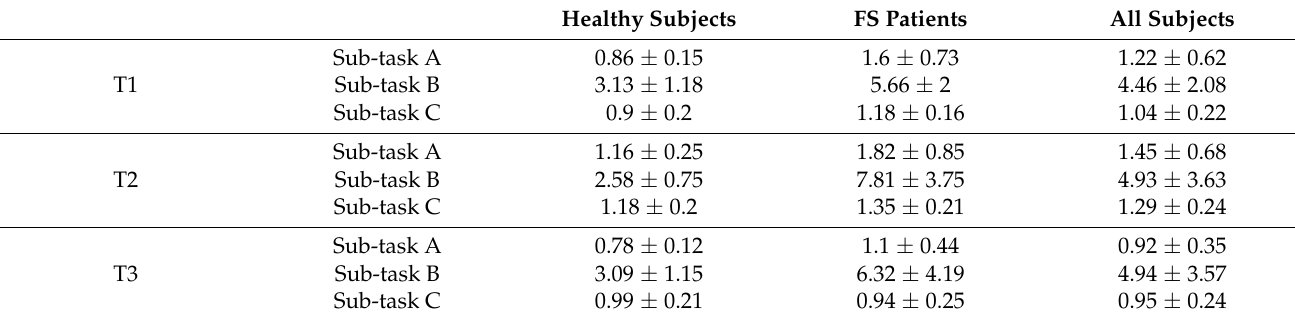
Table 2. Mean sub-task time performed by healthy and FS patients (s).